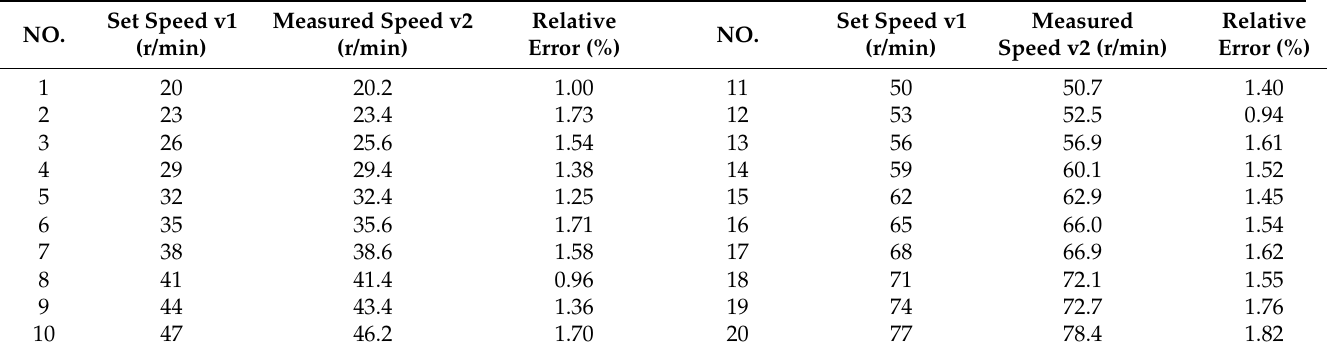
Table 3. Electric steering wheel speed collection record table.